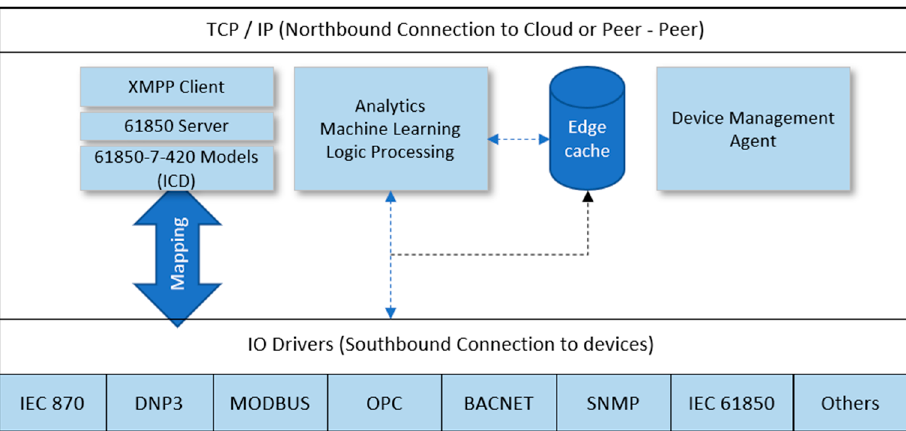
Figure 2. Architecture of edge computing gateway.